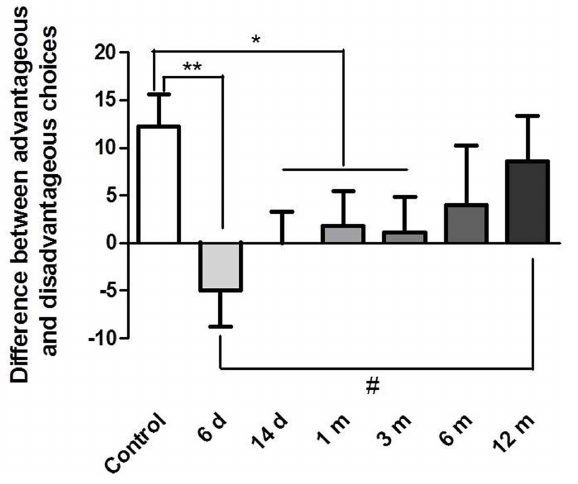
Figure 1. Decision-making ability on the Iowa Gambling Task (IGT) in METH abusers at different abstinence times and healthy controls over 100 card choices. Differences between advantageous and disadvantageous choices ([C + D] - [A + B]) are expressed as mean 6 SEM. * p , 0.05, differences between METH abusers groups and normal controls ( post hoc t -test). # p , 0.05, differences between 6 d and 12 m abstinence group.